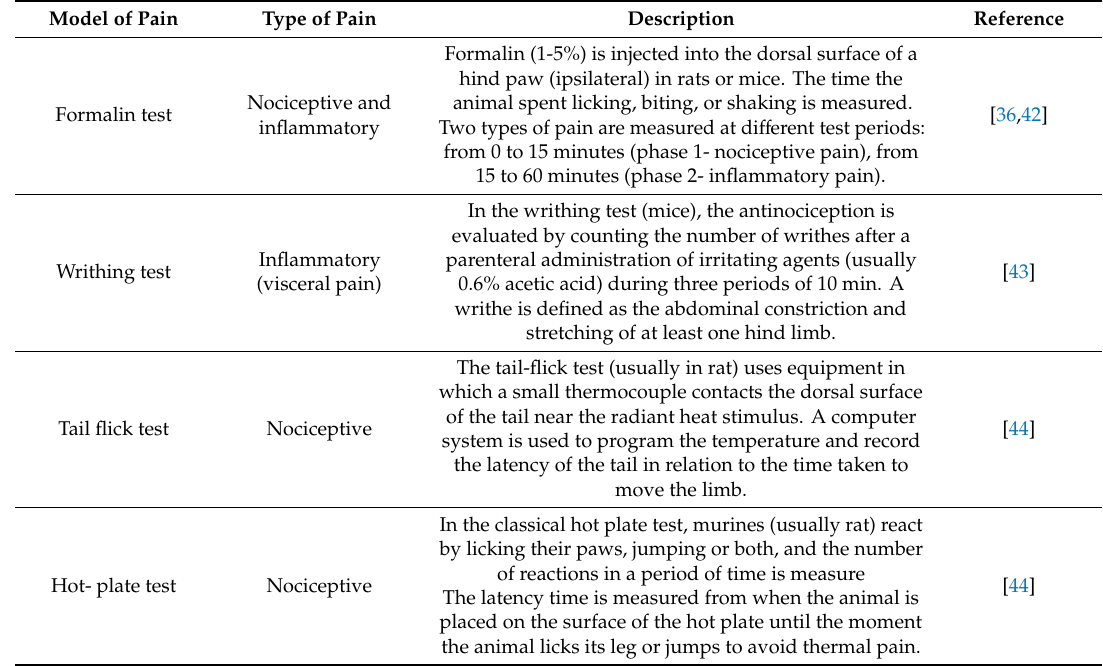
Table 1. Pain models used in pomegranate